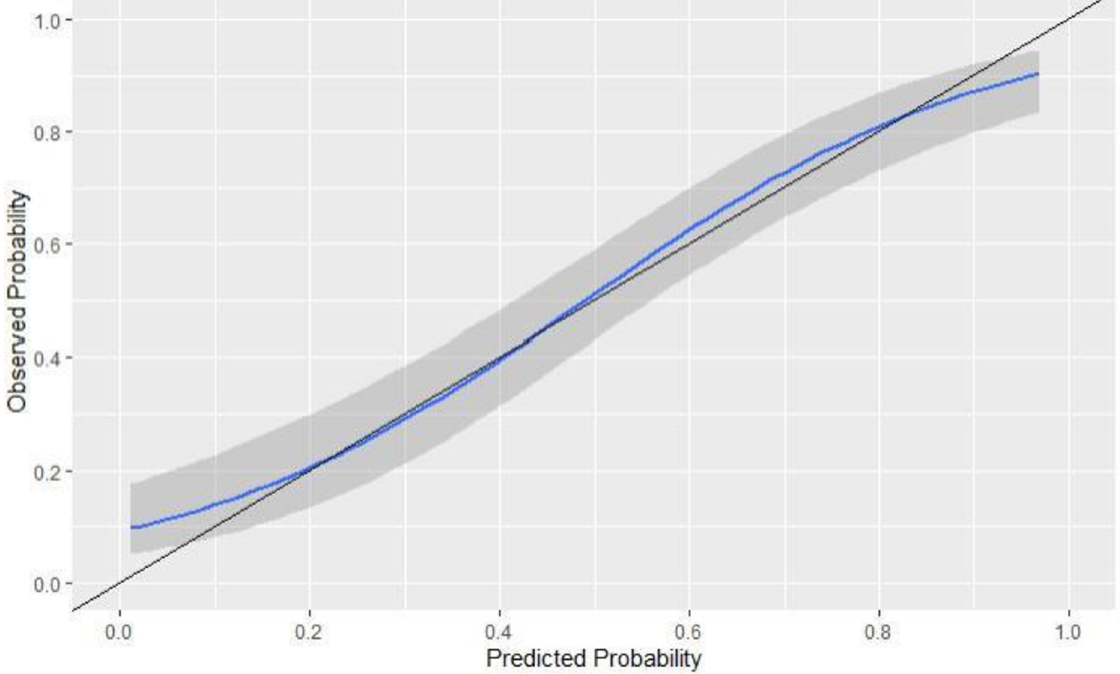
Fig 4. A calibration plot of the 1-year ED model. The solid black line represents an ideal model where the predicted probabilities correspond with the actual probabilities. The gray band represents the standard error of the mean (SEM) while the solid blue line shows the performance of the